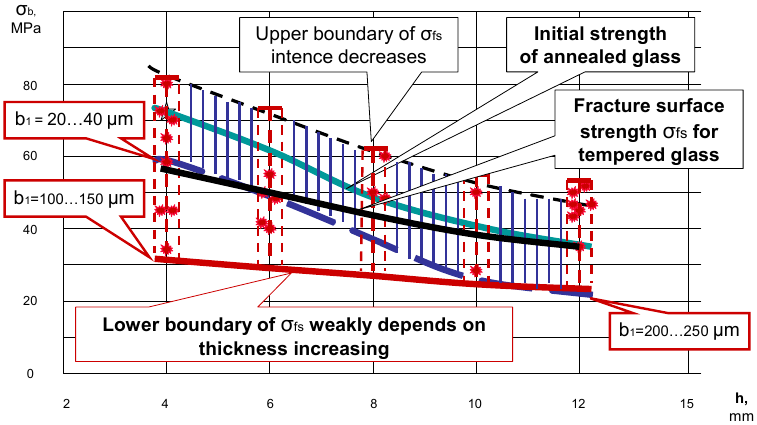
Figure 7 Influence of glass thickness on decreasing of glass surface mechanical resistance under the tempering conditions.